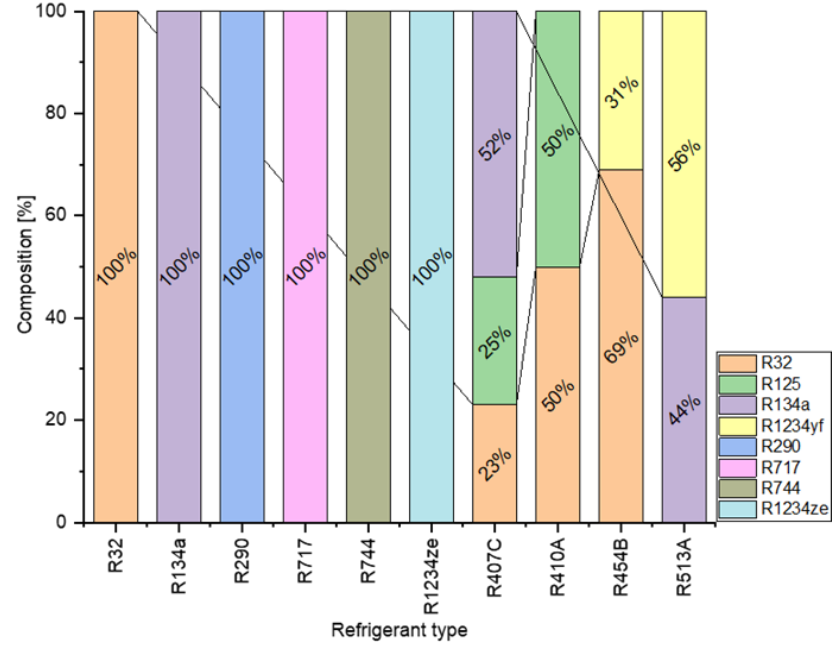
Figure 5. Percentage composition of selected refrigerants [29].